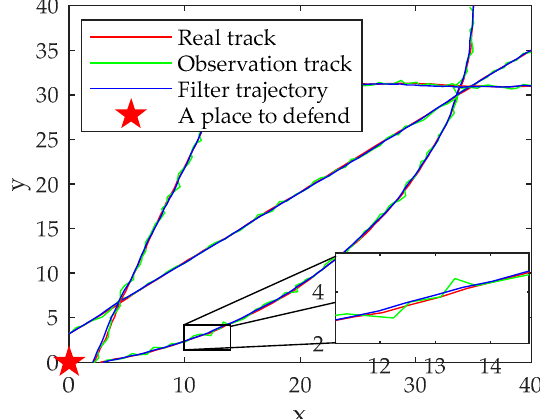
Figure 4. Target tracking trajectory graph.